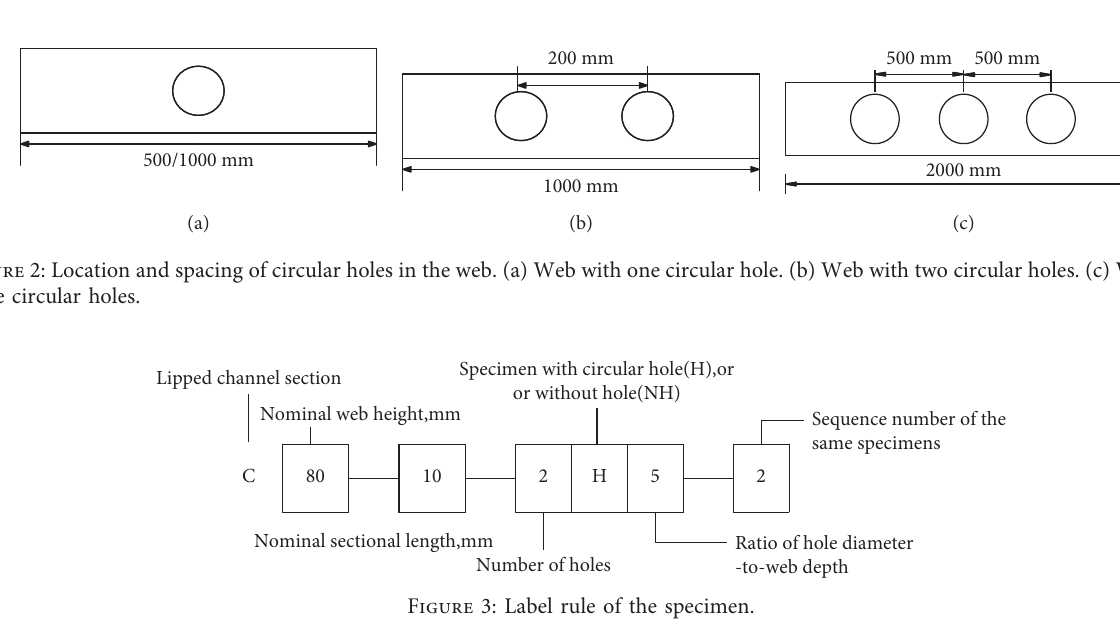
Figure 1: Section definition of CFS lipped channel columns with circular holes.